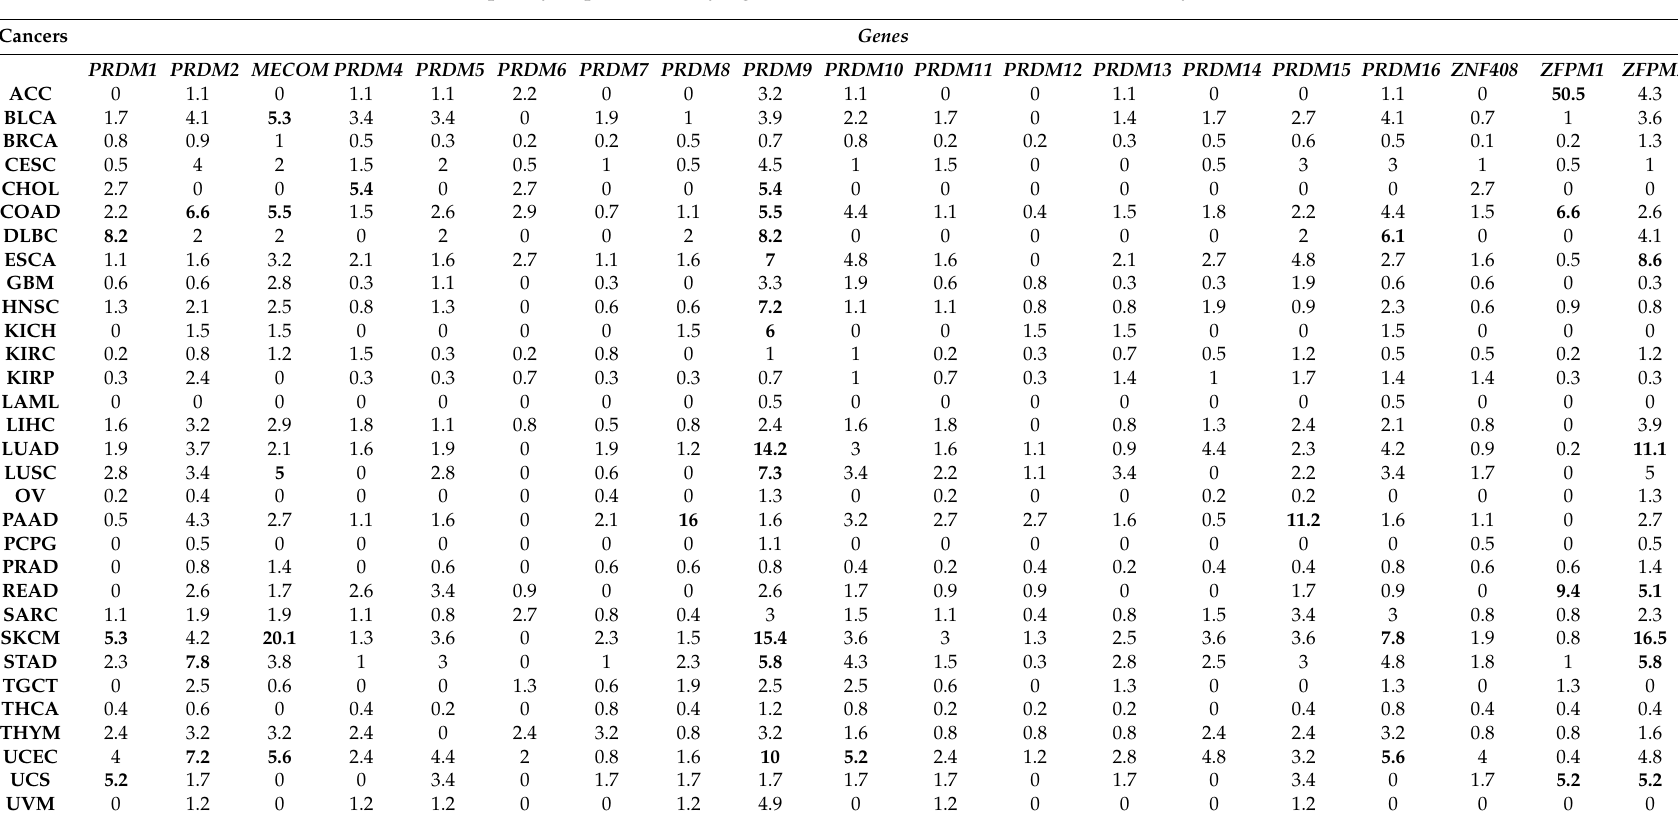
Table 1. Frequency of patients carrying mutations in the PRDMs across the 31 analyzed